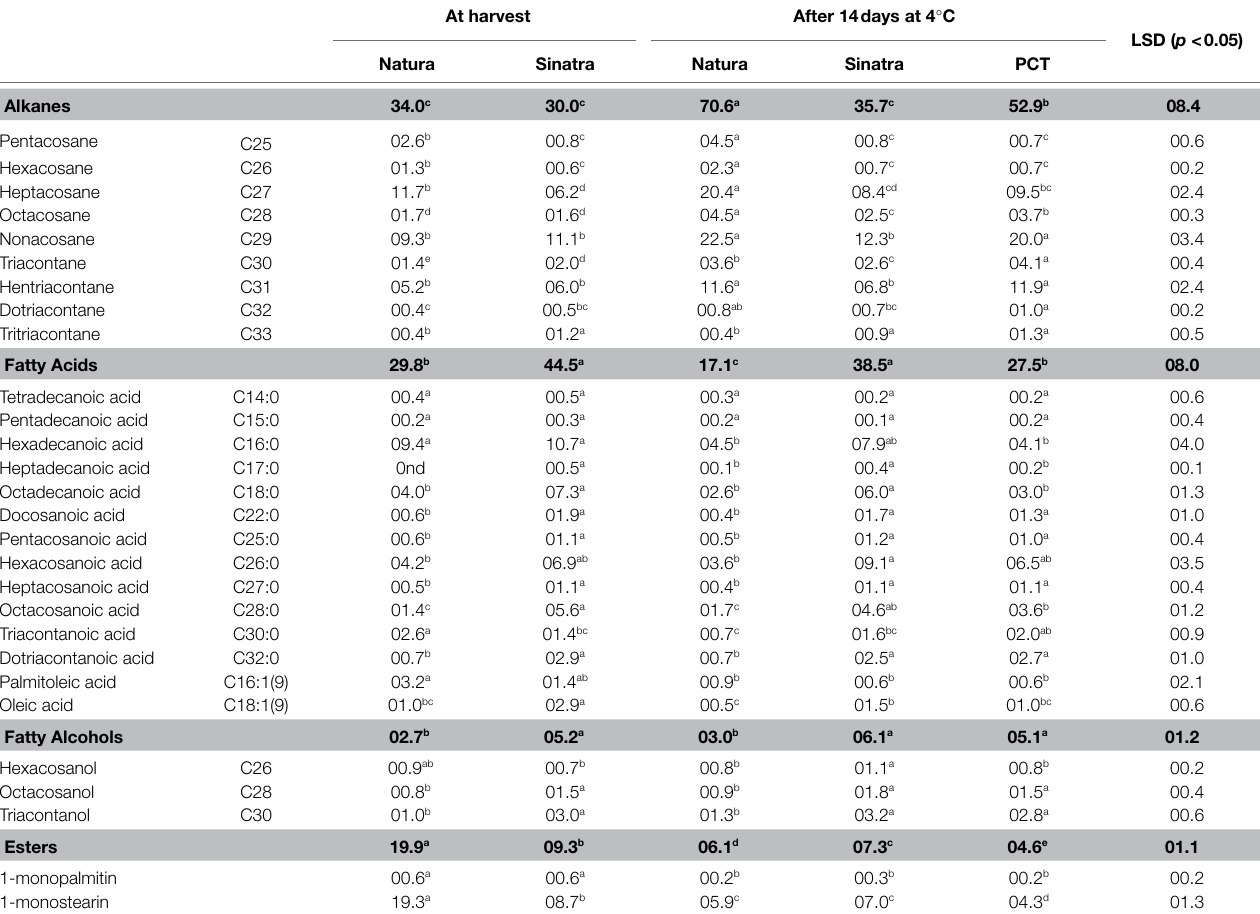
TABLE 1 | Relative content (%) of wax compounds in Natura (cold-tolerant variety), Sinatra (cold-sensitive variety) and PCT (preconditioned treatment in Sinatra) zucchini fruit at harvest and stored during 14 days at 4 ° C. At